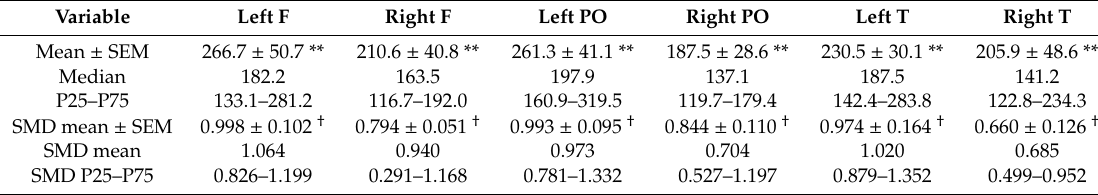
Table A9. Changes in power of beta bands during FS.